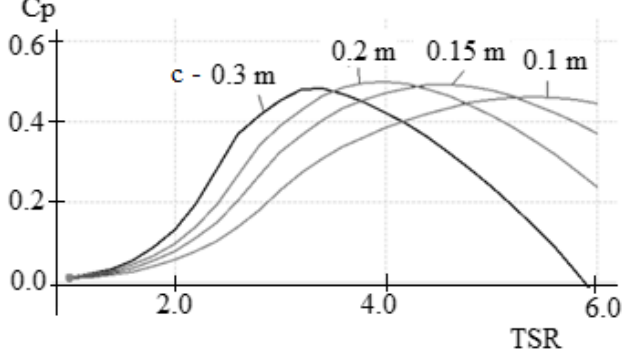
Figure 2. Power coefficient dependence on chord